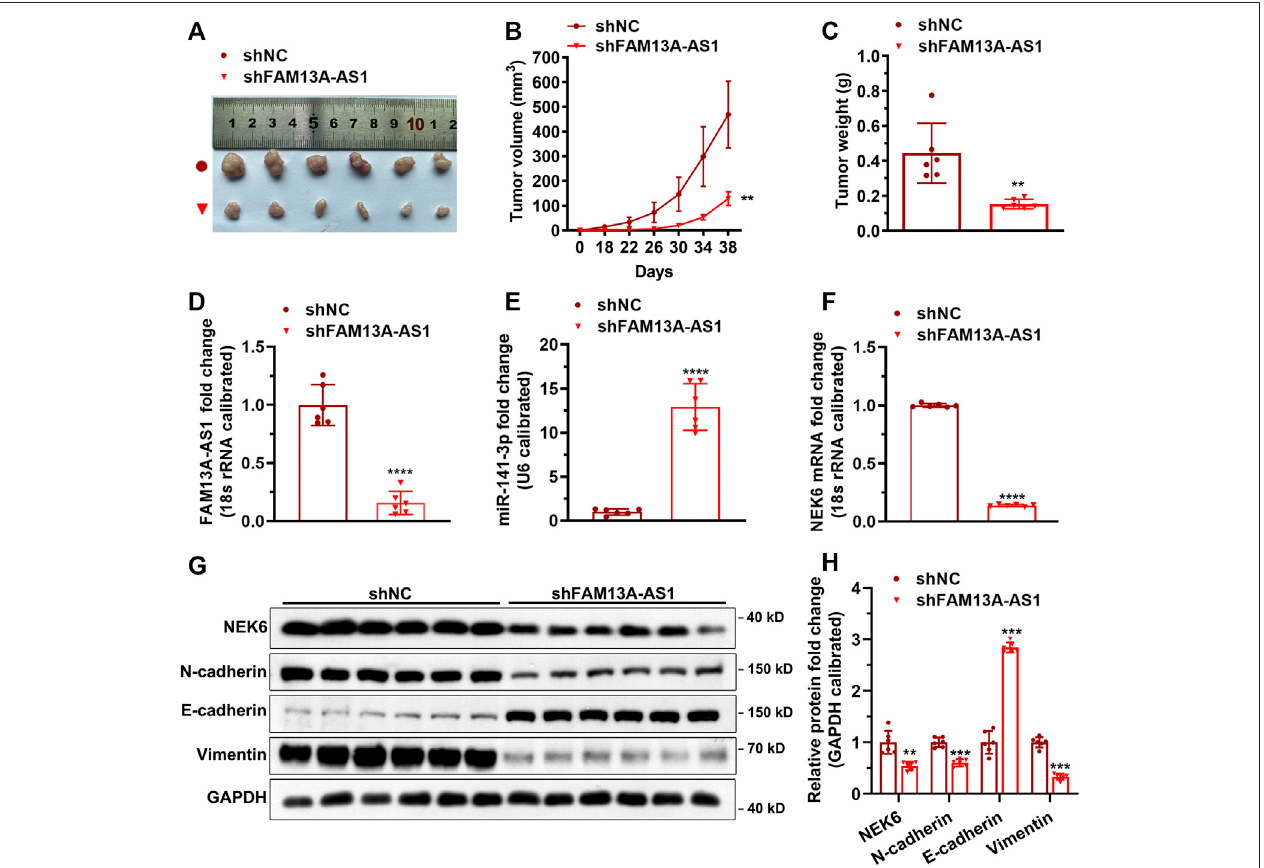
FIGURE 8 | FAM13A-AS1 promotes tumorigenesis in vivo . (A-C) Xenograft tumor model was constructed by transplanting the above 786-O cells into nude mice with representative images (A) , measurement of tumor volume (B) , and tumor weight (C) . (D-F) Expression of FAM13A-AS1 (D) , miR-141-3p (E) , and NEK6 (F) in the tumorsrevealed byRT-qPCR,calibrated using theexpression level of18SrRNAor U6. Fold changesofexpression werethen computed against the scrambled control. (G,H) Blotting images (G) and quanti fi cation (H) of protein levels in the tumor tissues ( n = 6). Data represent the mean ± SD. **: p < 0.01; ***: p < 0.001; ****: p <